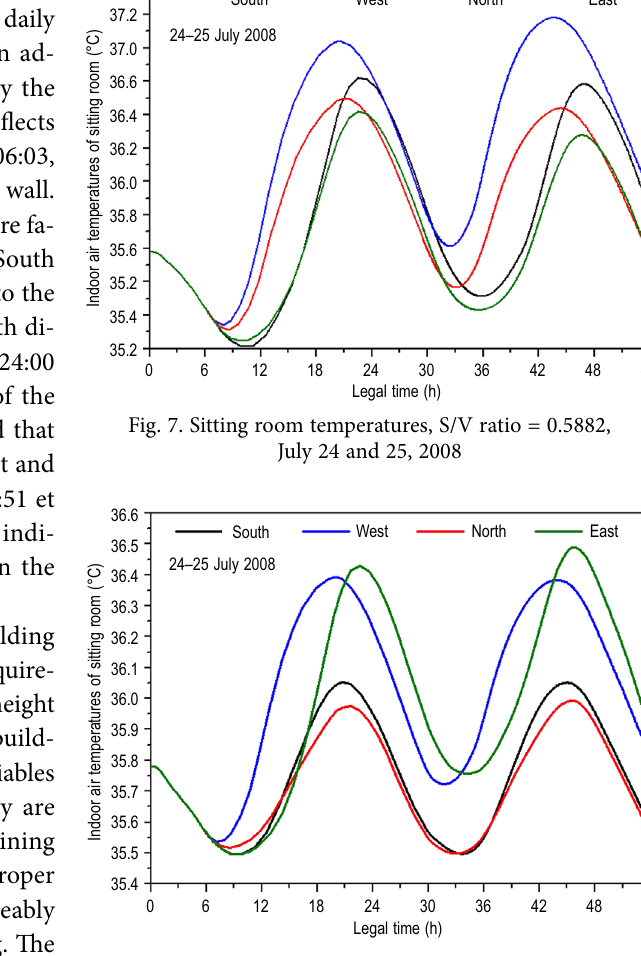
Fig. 8. Sitting room temperatures in the case of stone, S/V ratio = 0.27, July 24 and 25,